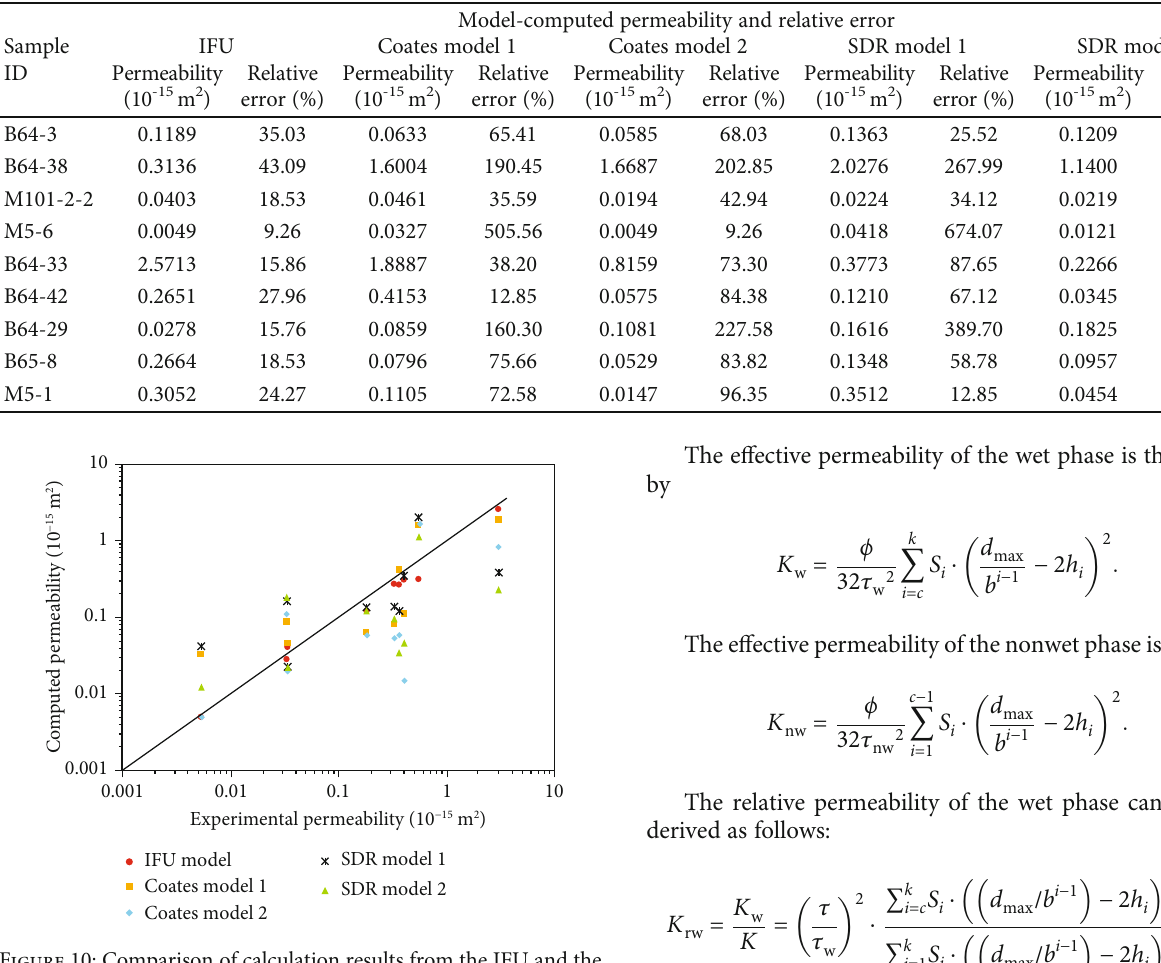
Figure 10: Comparison of calculation results from the IFU and the classic